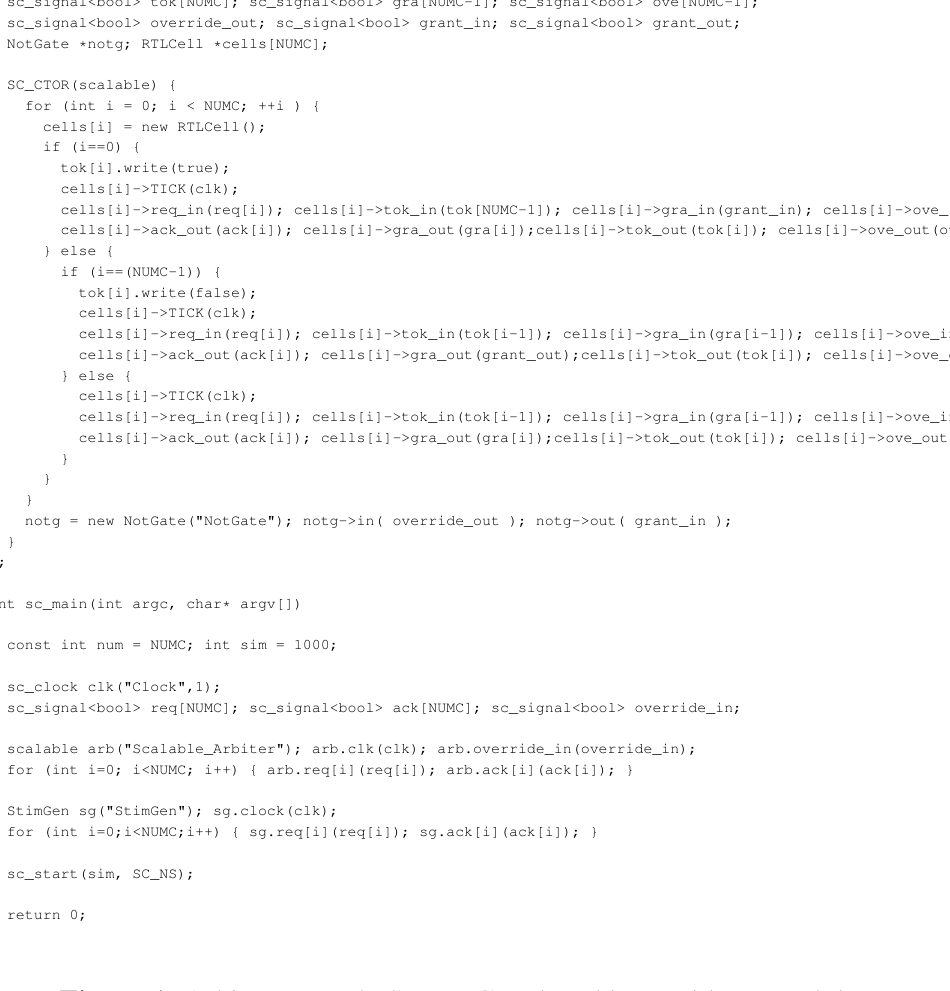
Figure 1. Arbiter example SystemC code. This provides a module scalable that